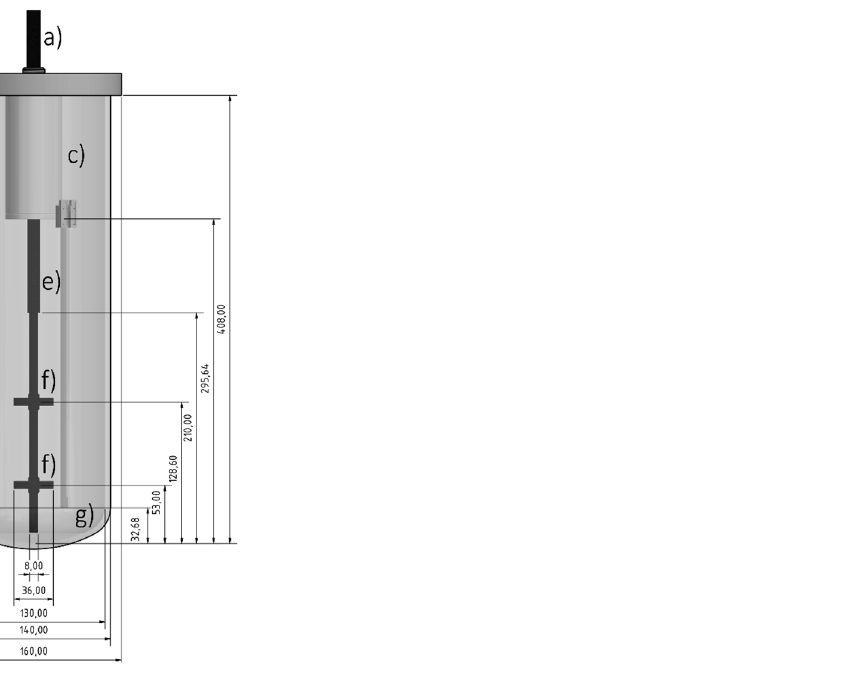
Figure 1. Geometry of the bioreactor. Shaft mount ( a ), lid ( b ), bearing box ( c ), baffles ( d ), shaft ( e ), impeller ( f ), vessel ( g